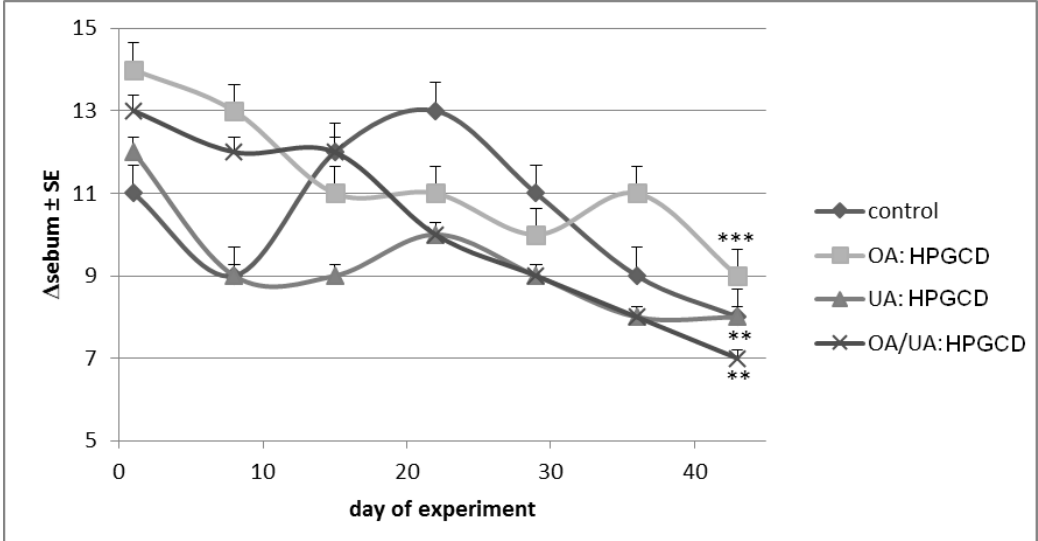
Figure 9. Sebum content.